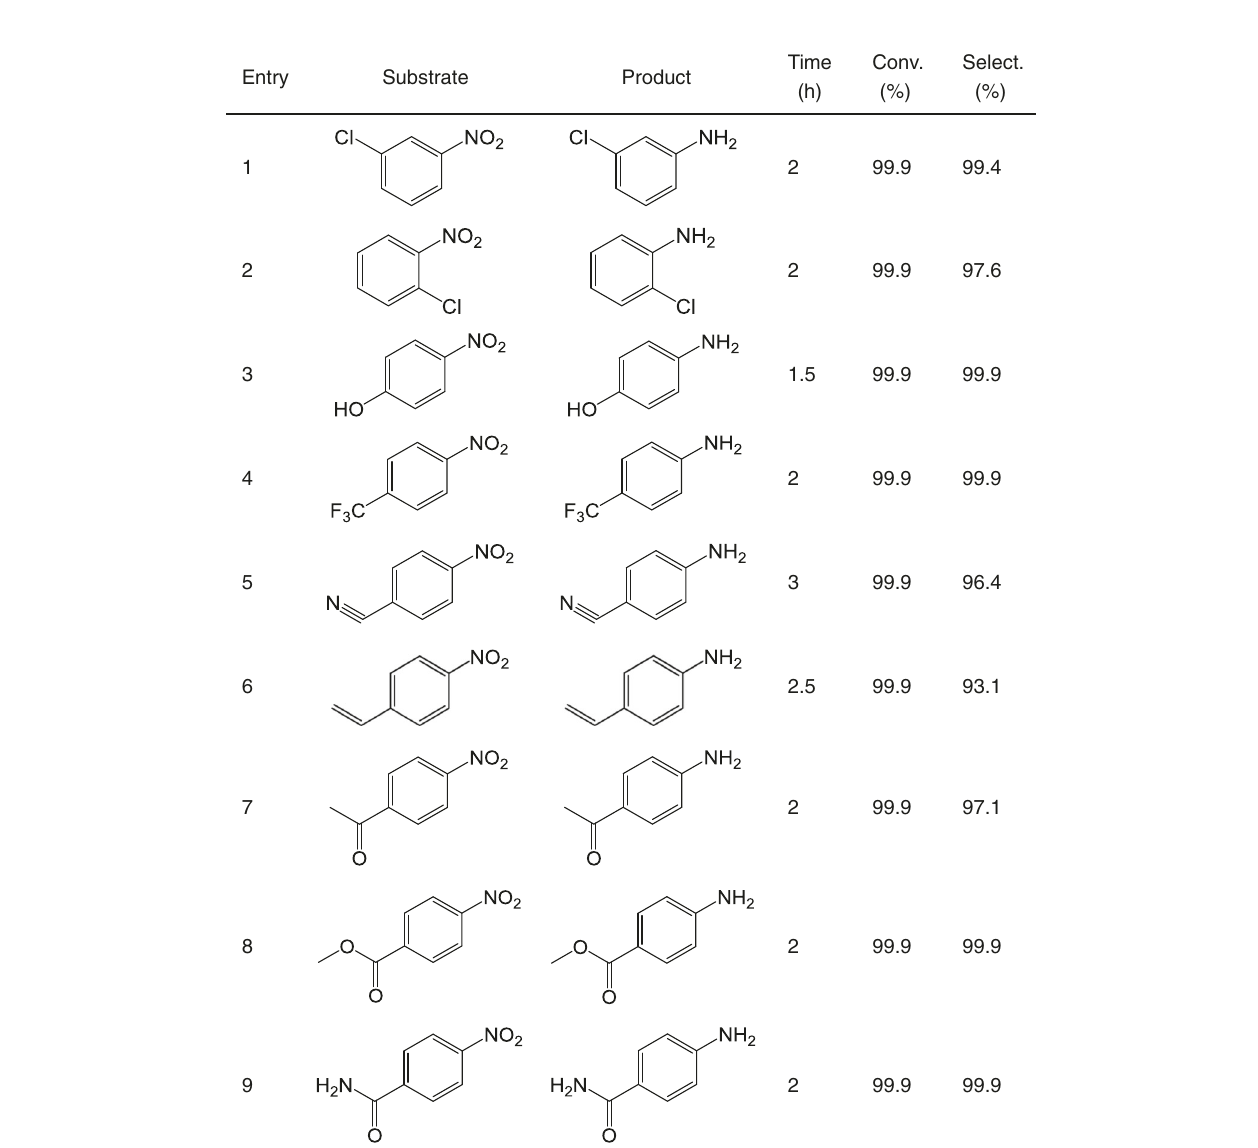
Table 2 Selective hydrogenation of substituted nitroarenes over the 0.1Pt/C12A7